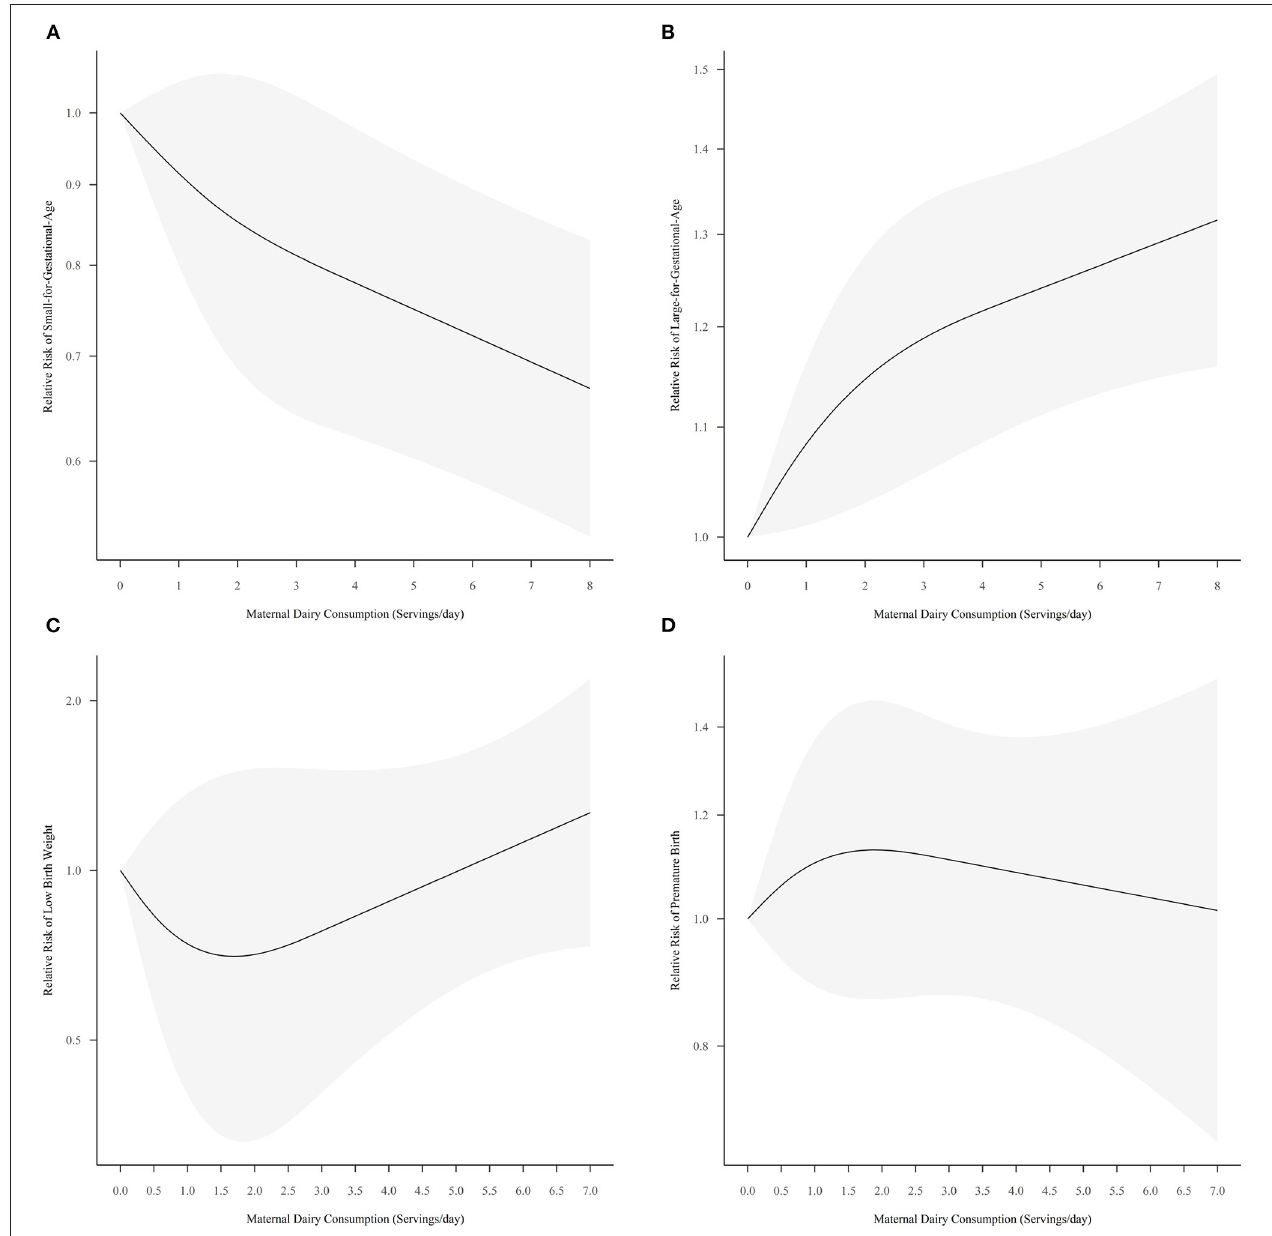
FIGURE 3 | Pooled dose-response curves for the risk of small-for-gestational-age (A) , large-for-gestational-age (B) , low-birth-weight (C) , and pre-mature-birth (D) with maternal dairy consumption. The gray part in this figure represents the 95% confidence